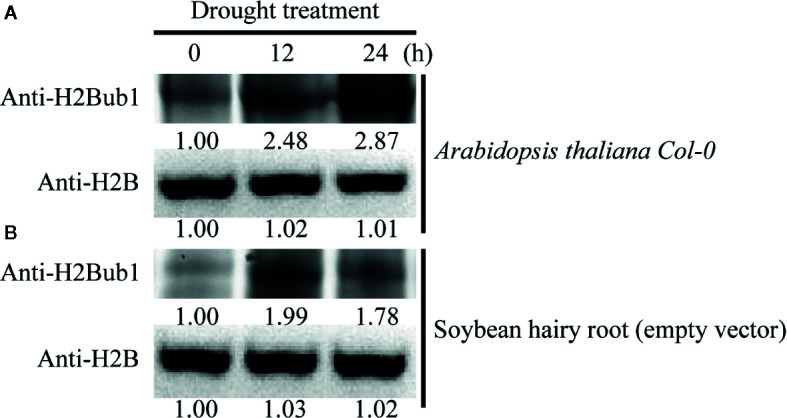
Alteration of Histone H2B monoubiquitination (H2Bub1) modification during drought response. (A) The H2Bub1 level detected by western blot under drought stressed Arabidopsis roots. (B) The H2Bub1 levels in soybean hairy roots were evaluated via western blotting. H2B served as a loading control in (A) and (B). Band intensities normalized to the first lane to the left are shown under each band.